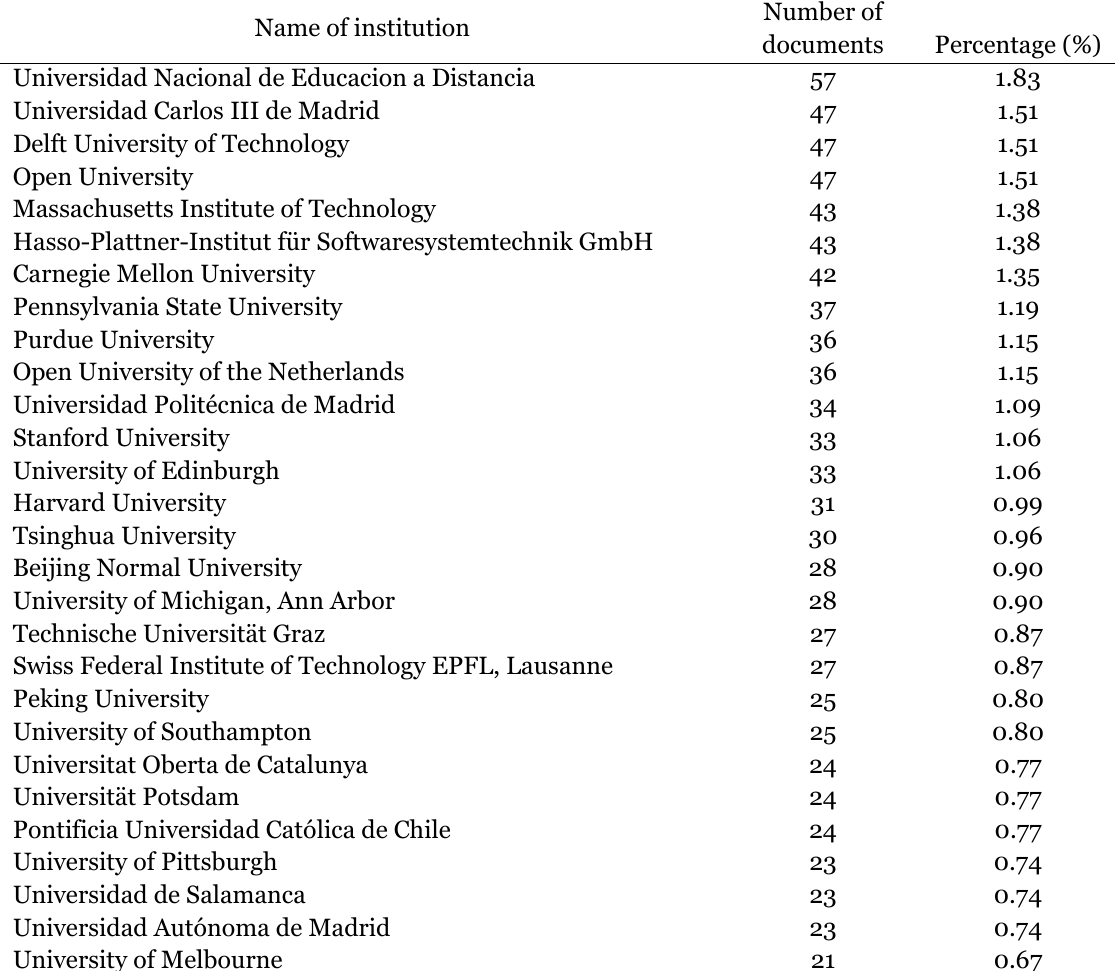
Institutions Contributing More Than 20 MOOCs Research